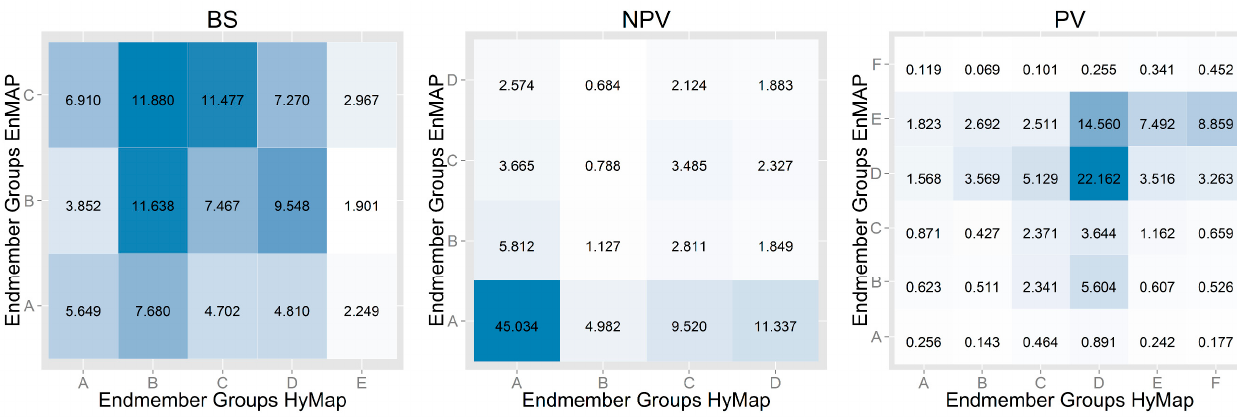
Figure 7. Density scatterplots of BS, NPV and PV fractional abundance results for EnMAP compared to the HyMap imagery with associated slope, intercepts and calculated R 2 values.